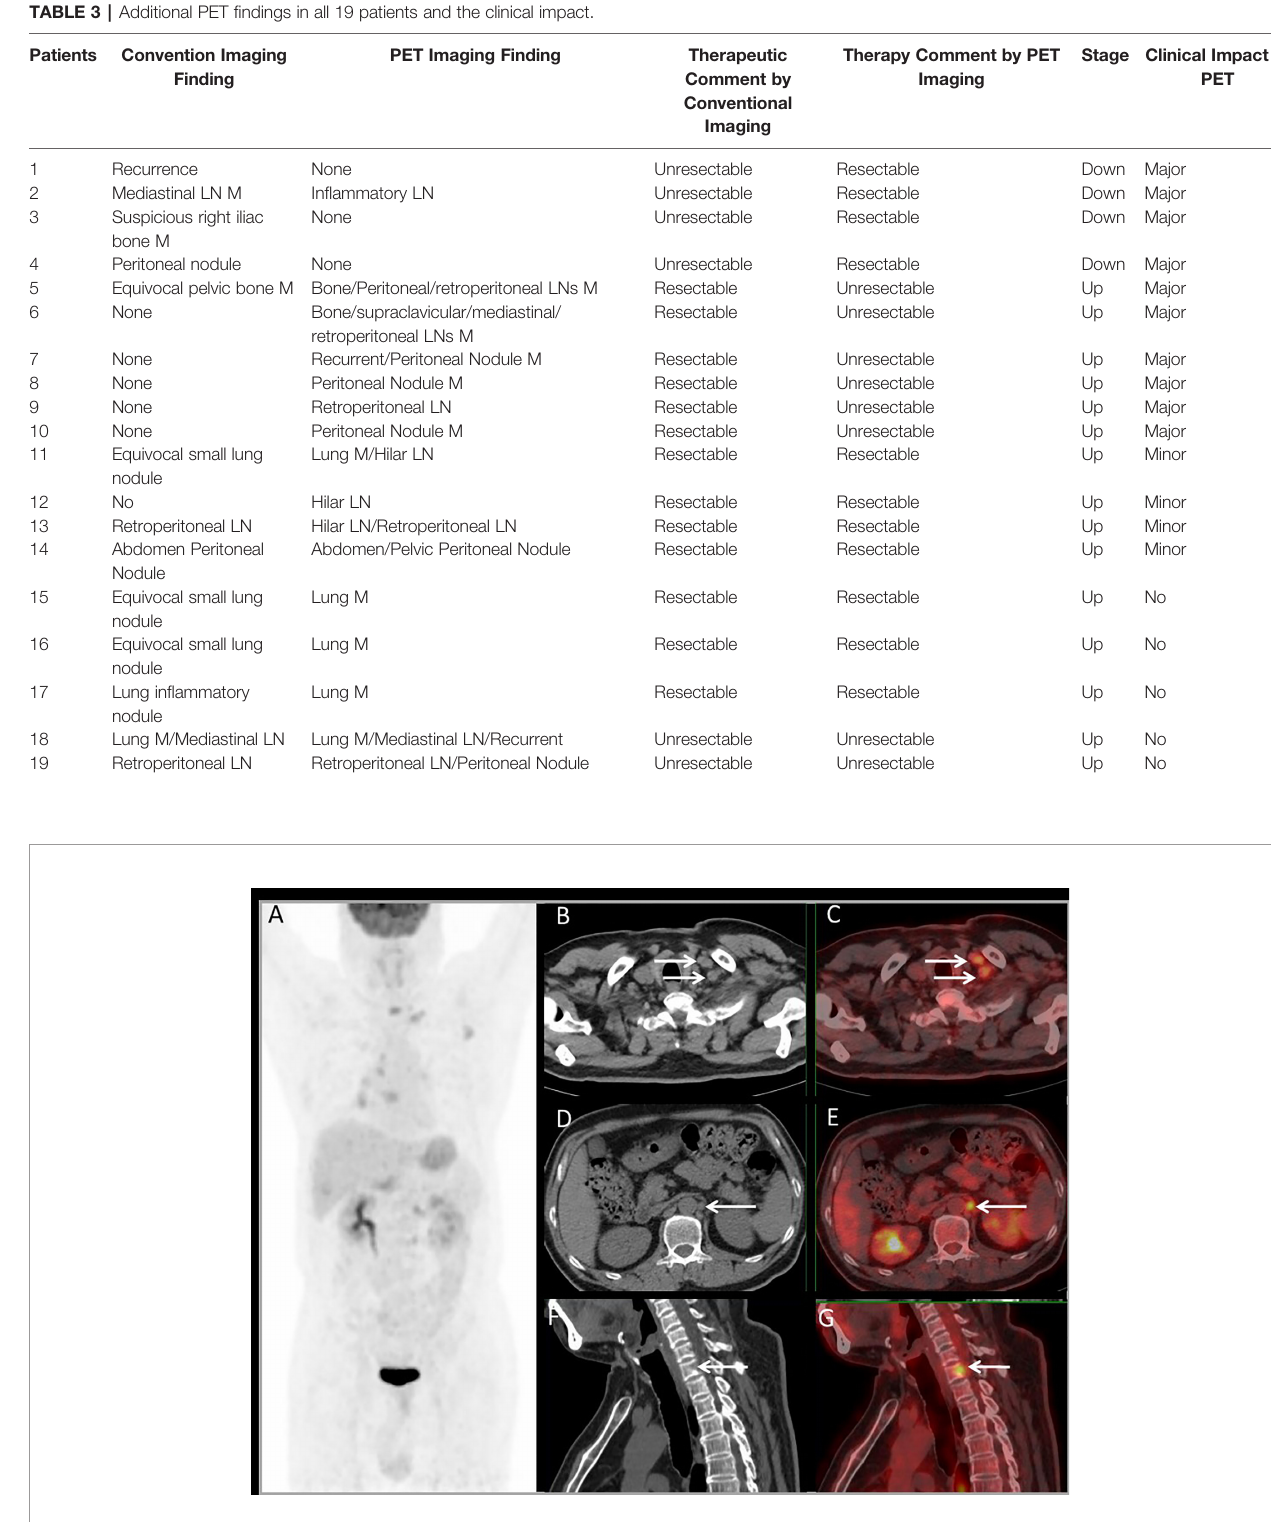
Frontiers in Oncology |